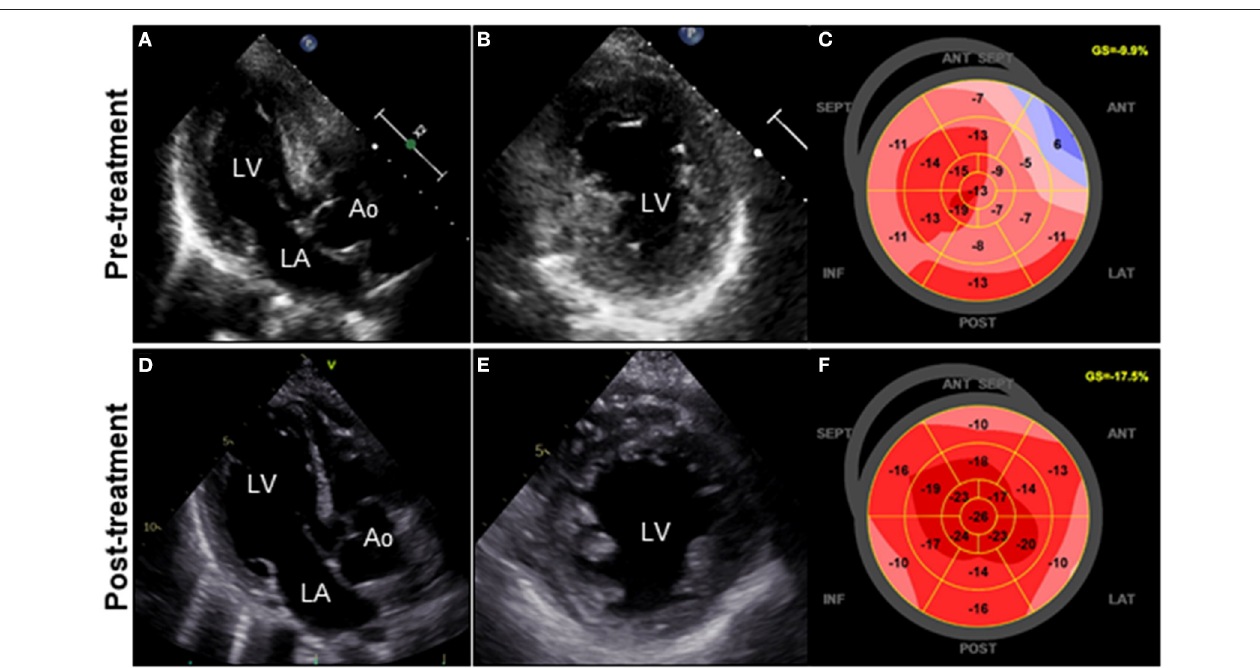
FIGURE 1 | Clinical effects of corticosteroid treatment on TTE. TTE on admission reveals diffuse and symmetrical LV wall thickening (11mm), decreased cavity size, reduced ventricular function, and GLS values of the LV (LVDd, 44mm; LVEF, 43%; and GLS, − 9.9%; respectively) (A–C) . Follow-up TTE on day 21 after corticosteroid therapy reveals a significant decrease in LV wall thickness (8mm) with concomitant improvement in cavity size, ventricular function, and GLS values of the LV (LVDd, 48mm; LVEF, 50%; and GLS, − 17.5%; respectively) (D–F) . Ao, aorta; GLS, global longitudinal strain; LA, left atrium; LV, left ventricle; LVDd, left ventricular end-diastolic diameter; LVEF, left ventricular ejection fraction; TTE, transthoracic echocardiography.